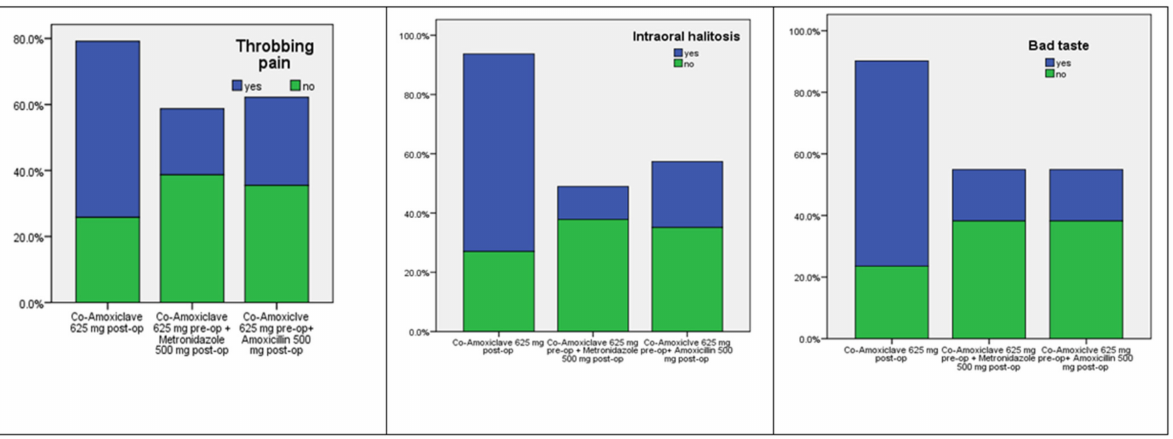
Figure 2. Distribution of the dry socket symptoms occurrence for the patients in the co-amoxiclav, co-amoxiclav plus metronidazole and co-amoxiclav plus amoxicillin